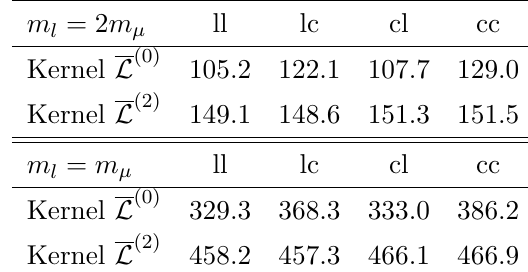
Table 5 . Results for a LbL in units of 10 − 11 from the lepton loop of mass m l = 2 m µ or m l = m µ µ obtained with Method 2 by extrapolating the lattice results displayed in figures 11 and 12 to the continuum. Two different kernels and four discretizations of i b Π employing different combinations of local (l) and conserved (c) vector currents are used. The exact results are a LbL 464 . 97 respectively [81,